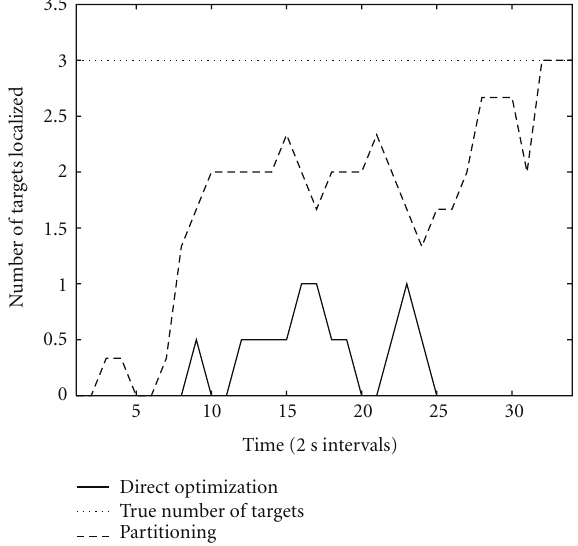
Figure 18: Comparison of sample mean average partition size of partitions containing targets over simulation time between state- of-the-art direct distribution optimization and partition learning classification path planning approaches.